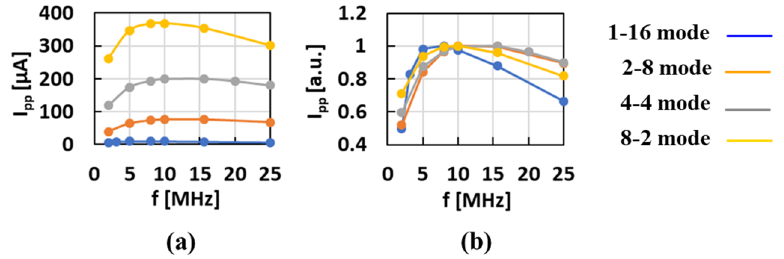
Figure 6. Clock frequency vs. output current at V PP of 3.0V. ( a ) absolute value; ( b ) arbitrary unit.